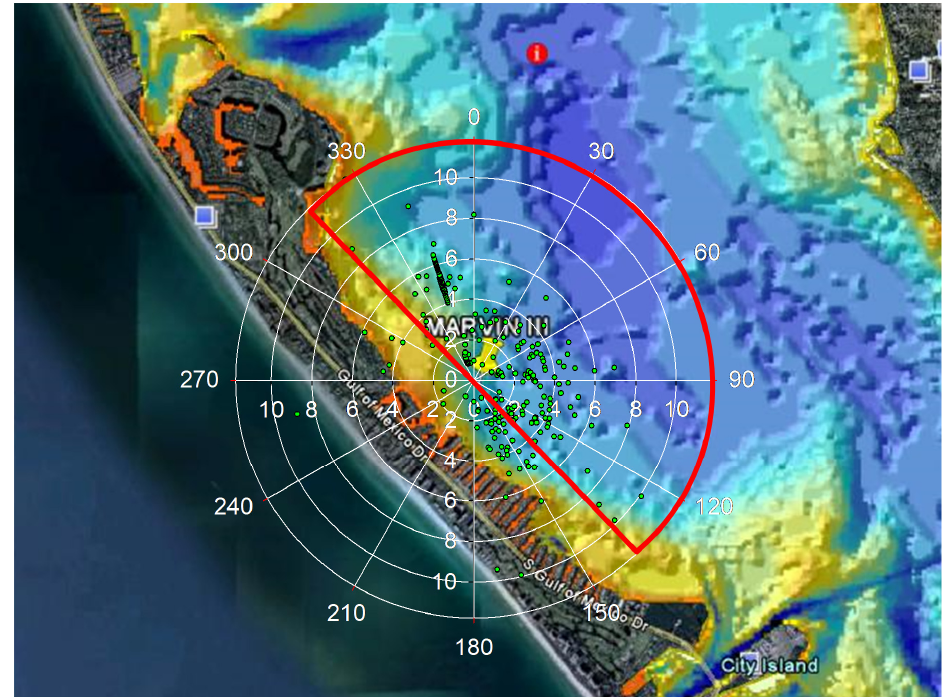
Figure 10. Compass diagram showing the urea concentration (green dots) and associated water current direction, in relation to the MARVIN platform, measured during the 2009 deployment. The red hemisphere represents all the current directions away from the shore. Background image, Google Earth 2009.